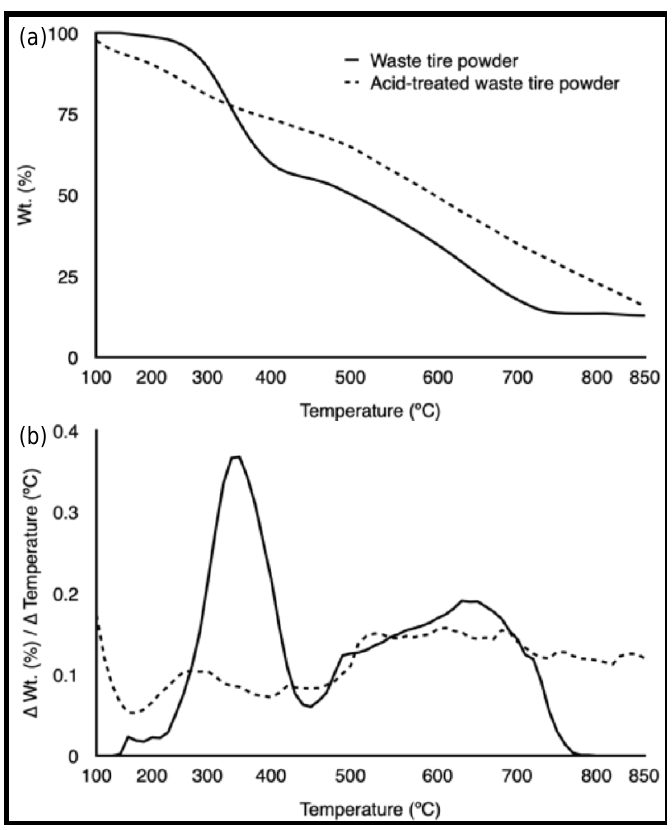
Figure 3. Thermogravimetric analysis performed under N 2 atmosphere: ( a ) thermograms and ( b ) derivative thermograms of waste tire powder and acid-treated waste tire powder.